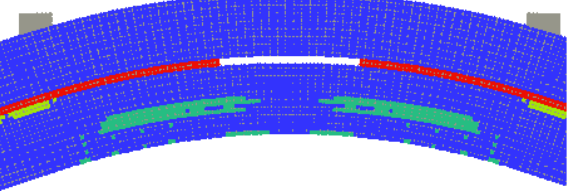
Figure 7. Arch crown cracking in FE simulation: primary and secondary